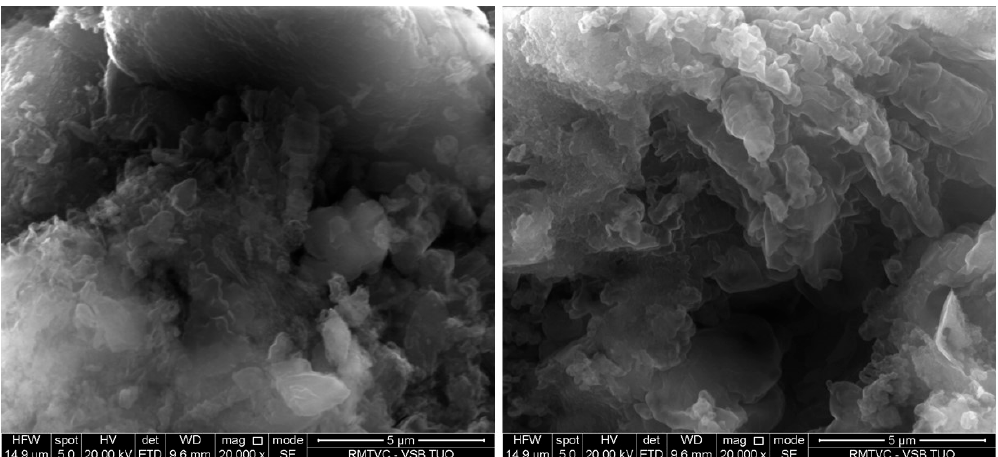
Figure 8 . SEM images of bulk ( left ) and bulk 30 % H 2 O 2 nanomaterials ( right ).